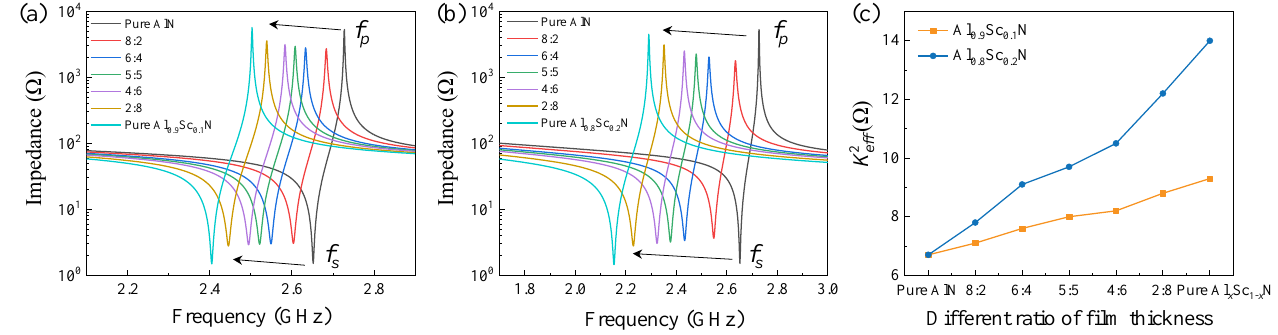
Figure 3. Simulated results of FBAR with different piezoelectric materials. ( a ) Simulated impedance curves of FBARs based on AlN/Al 0.9 Sc 0.1 N composite film with different thickness ratios. ( b ) Simulated impedance curves of FBARs based on AlN/Al 0.8 Sc 0.2 N composite film with different thickness ratios. ( c ) Calculated 𝐾 𝑒𝑓𝑓2 of different FBARs. We also deposited the piezoelectric films and fabricated FBARs to verify the simulated results. The pure AlN, Al 0.9 Sc 0.1 N, and Al 0.8 Sc 0.2 N with a thickness of 1 µ m, respectively, were deposited on Si (100) substrate first. Further characterizations of piezoelectric ma- terials were carried out using XRD as shown in Figure 4a; it is used to assess the (002) preferred orientation and crystal quality of piezoelectric films. Significant reflection peaks at around 35 ◦ to 36.0 ◦ associated with the (002) hexagonal AlN and AlScN films in patterns indicate that the piezoelectric films are well-crystallized with the c axis. The peak positions of Al 0.9 Sc 0.1 N and Al 0.8 Sc 0.2 N films shift due to the Sc doping [13,26,27]. The results of XRD rocking curves in the insets of Figure 4a show full width at half maximum (FWHM) of 1.49 ◦ , 1.62 ◦ , and 1.65 ◦ for 1 µ m-thick AlN, Al 0.9 Sc 0.1 N, and Al 0.8 Sc 0.2 N films, respec- tively, suggesting a preferred c-axis crystal orientation as well [10,13]. Figure 4b shows the morphology of 1 µ m-thick Al 0.8 Sc 0.2 N film caught by Scanning Electron Microscopy (SEM, Tescan, MIRA3, Brno, The Czech republic). Although small grain growth precipitates can be observed in the relative smooth surface of Al 0.8 Sc 0.2 N film, distinct clusters of particles, normally deteriorating the film quality, are absent [28,29].